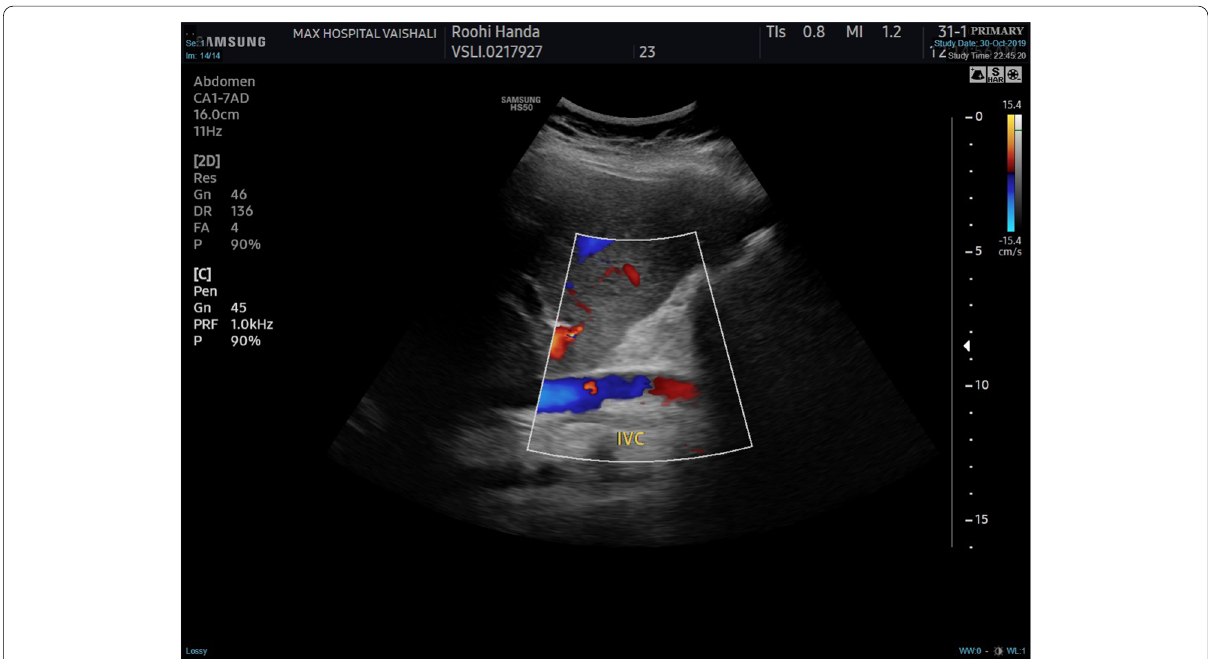
Fig. 9 Venous Doppler of the lower limb revealed deep vein thrombosis involving left common, external iliac, common, superficial and deep femoral, and popliteal veins with